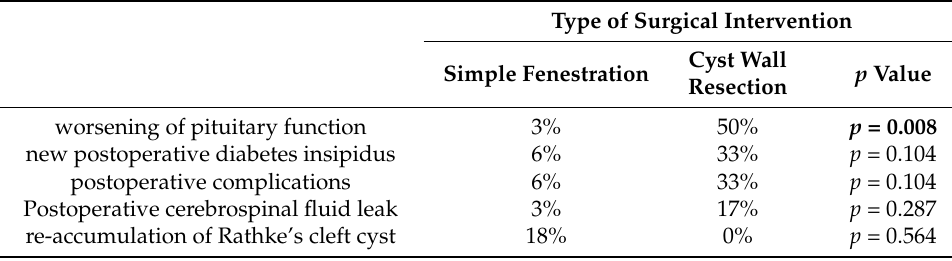
Table 3. Comparison of outcome to type of surgical